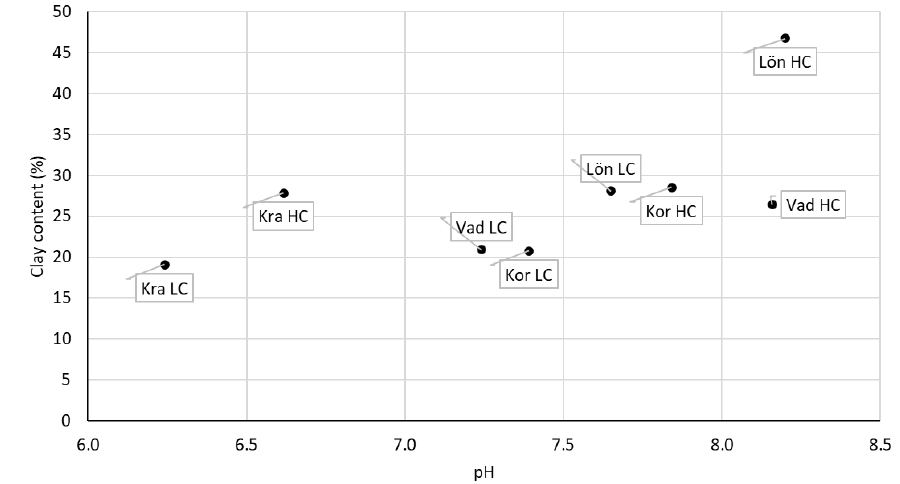
Fig. 1. Average initial pH and clay content in the eight field trials at spreading and incorporation H2O of structure lime in August–September 2014. Kra=Krageholm, Lön=Lönhult, Vad=Vadensjö, Kor=Kornheddinge, LC = lower clay content, HC = higher clay content. Actual clay content is given in Table